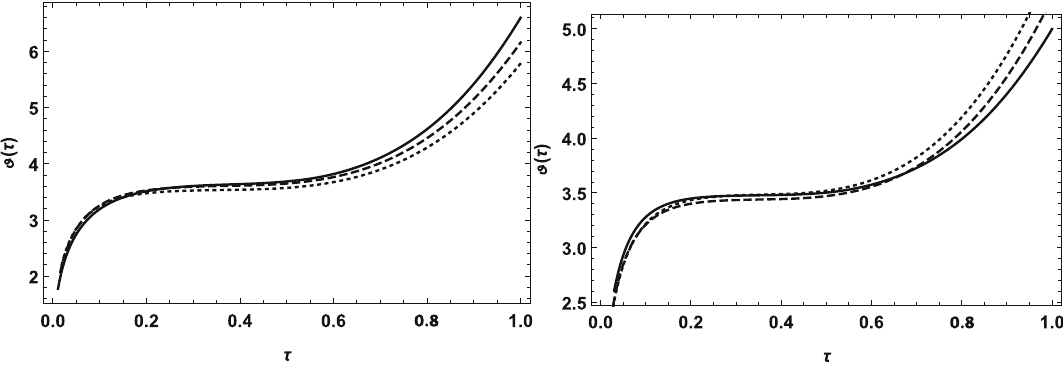
ϕ 2 + ς ϕ 4 andrightplotisfor V (ϕ) = + ν 2 2 4